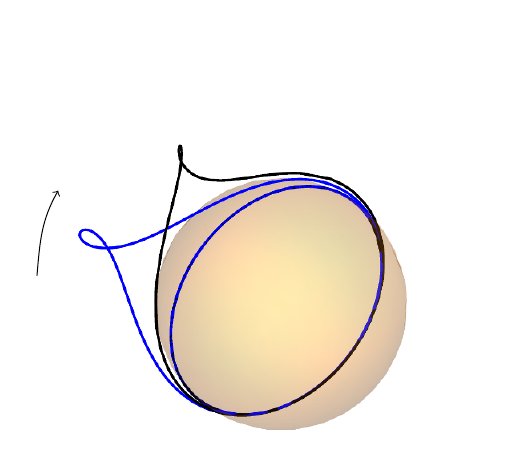
Figure 4 . Stereographic image of a giant magnon solution of the lambda model for 2 nearby times (black and blue). Note that the solution appears as a kink on a string that is wound in(cid:12)nitely around a